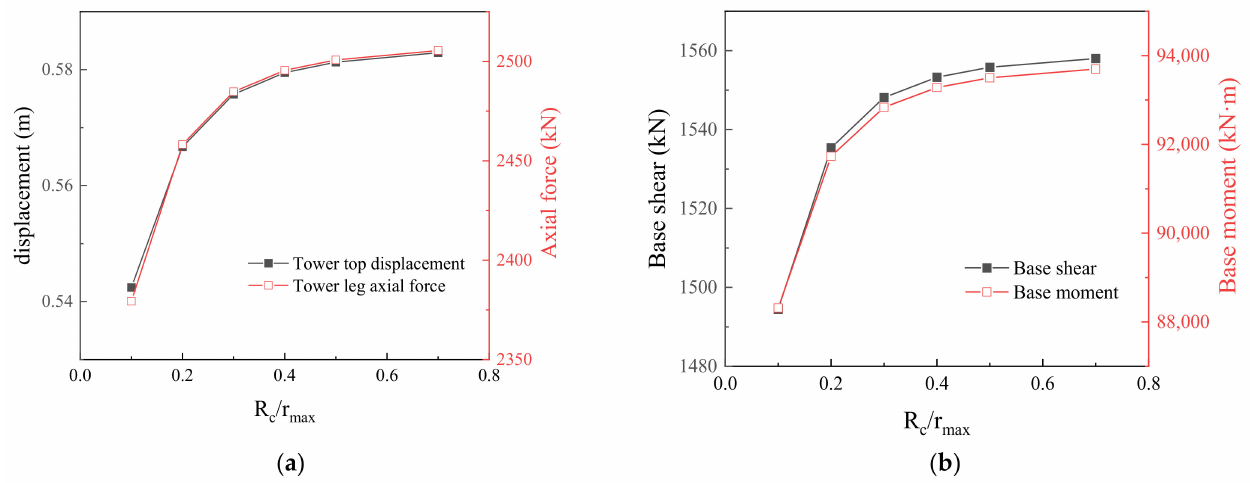
Figure 18. Wind-induced response of tower-line system changes with R c / r max ( a ) tower top displace- ment and tower leg axial force; ( b ) base shear and bending